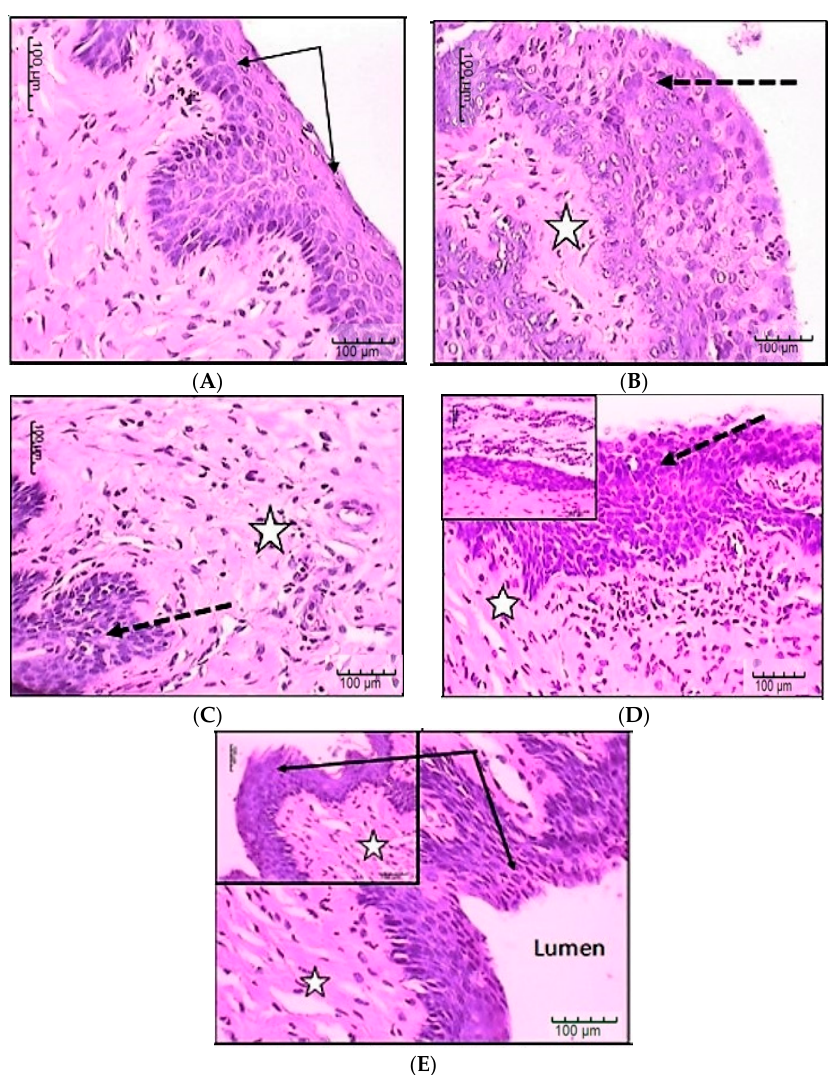
Figure 6. Histological examination of Candida infected vaginal tissue treated by unloaded vaginal insert, fluconazole PEC based vaginal insert and fluconazole solution. ( A ) Control normal vaginal tissue; ( B ) Control Candida infected, non-treated vaginal tissue; ( C ) Candida infected vaginal tissue